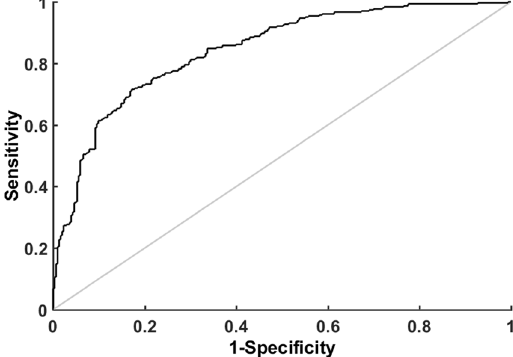
Figure 2. The ROC curve of SVM (liner). SVM (liner) achieved the best classification performance using network and GO functional